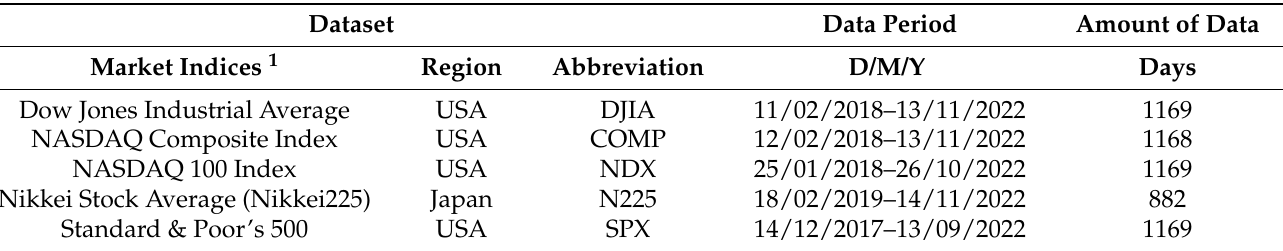
Table 1. Experimental